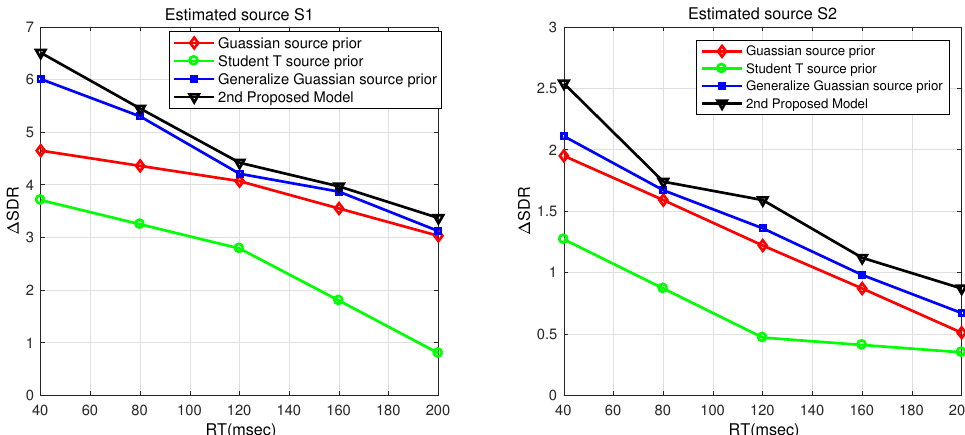
Figure 6. Change in SDR for convolutive pink noisy mixture with variable RT in the 2nd proposed